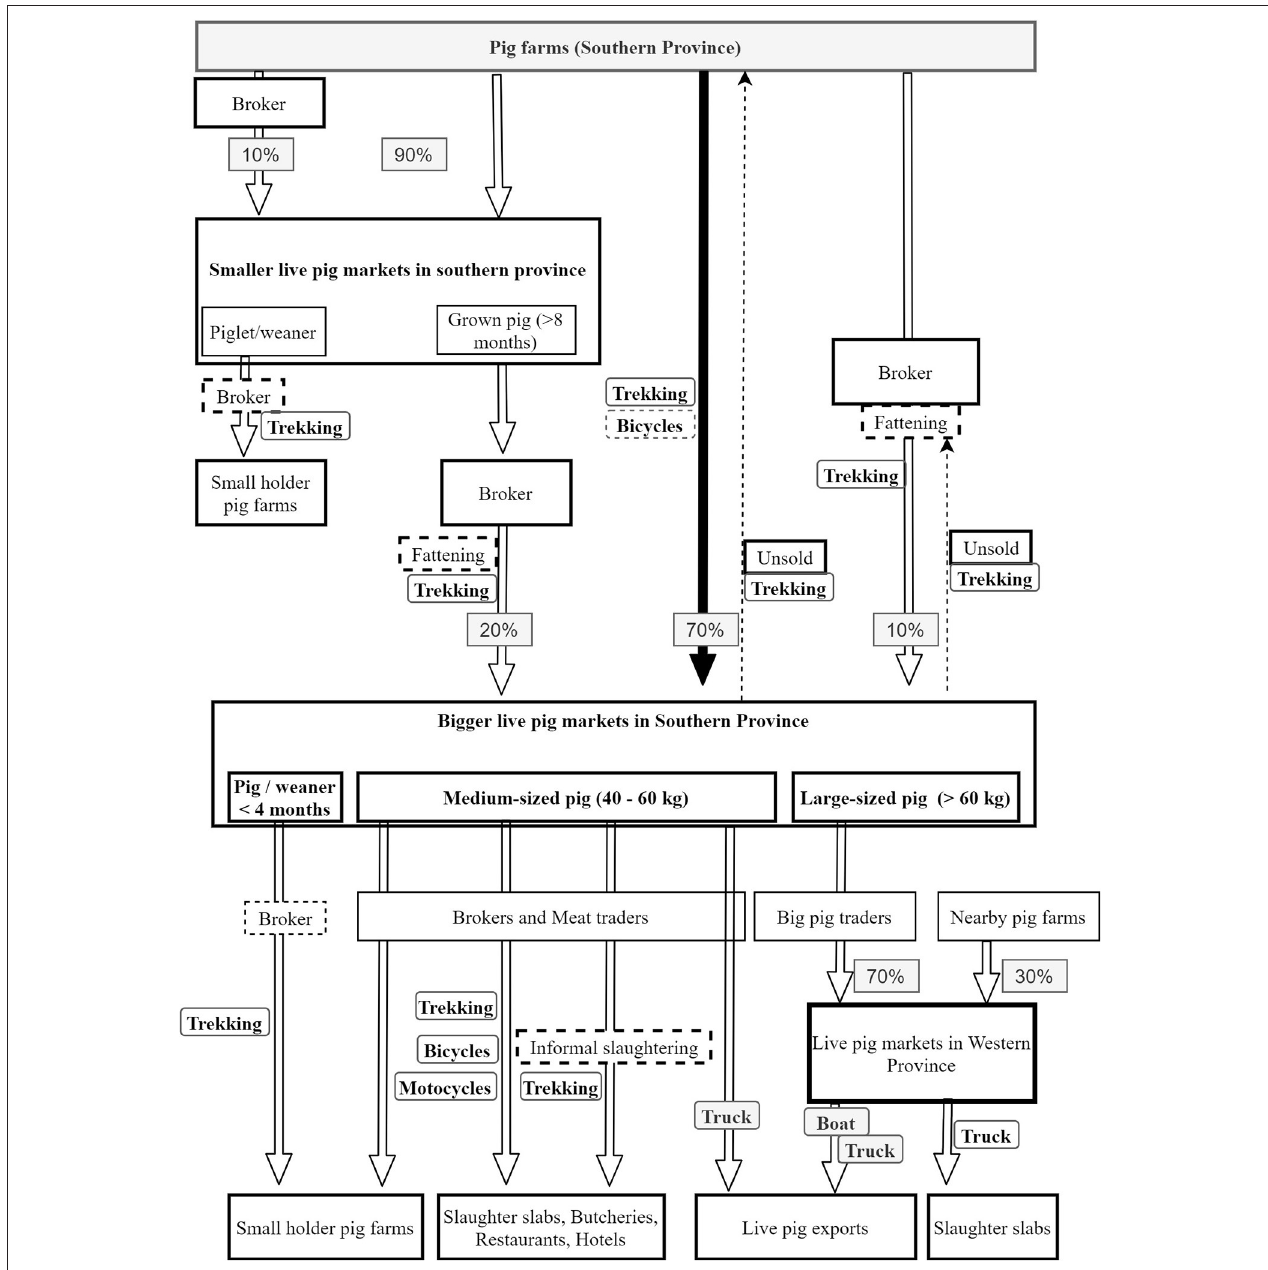
FIGURE 4 | Profile of Rwanda live pig markets. Flowchart indicates origins and destination of live pigs. Of note, live pig markets are found in Southern and Western provinces of Rwanda. The pigs from other provinces have their characteristic flows as explained in the pig farms profile.